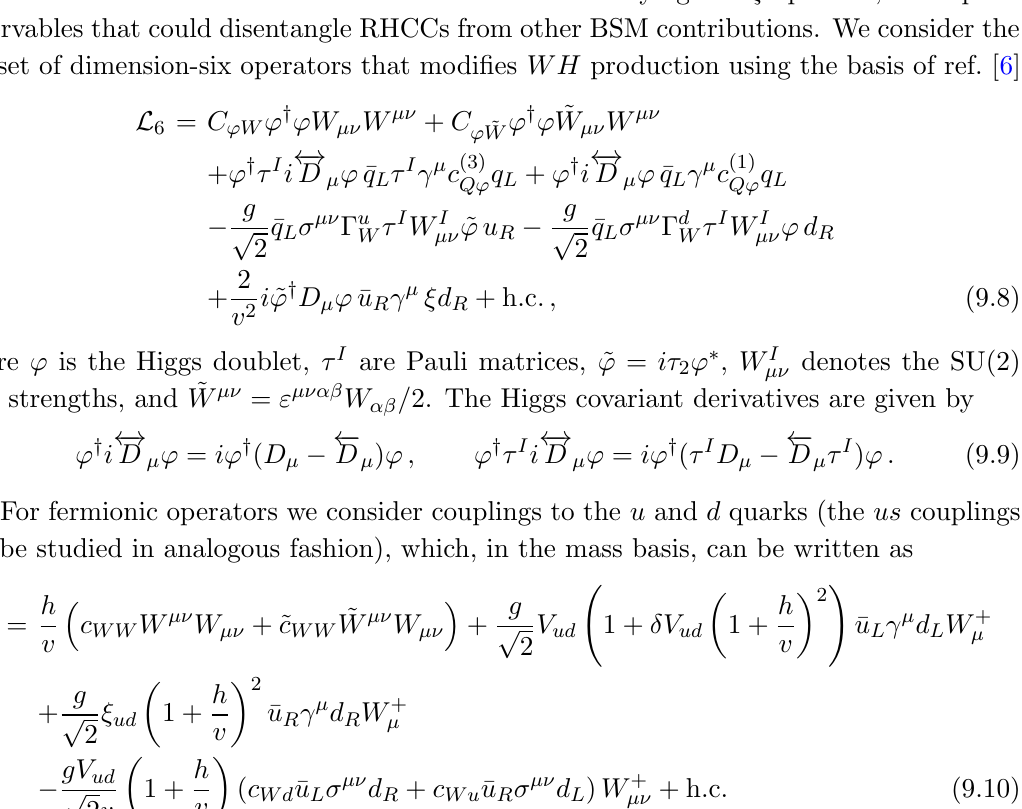
Figure 13 . W + H cross section for p W cross section, the remaining lines include the contributions of the operators in eq.